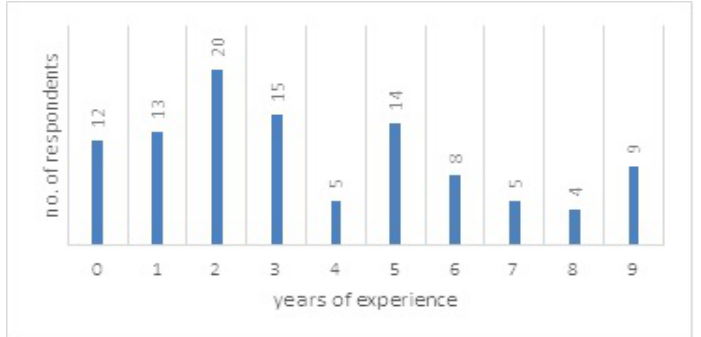
Fig. 2. No of respondents according to years of